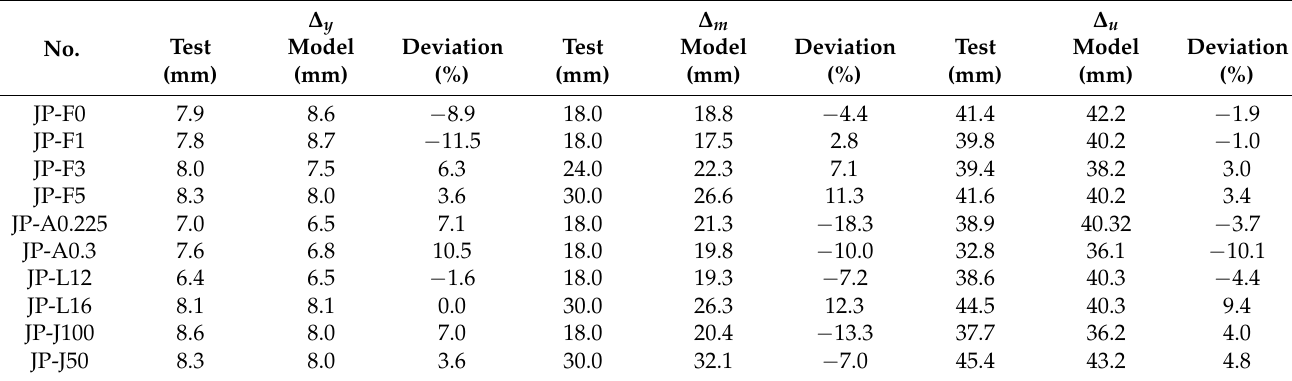
Table 8. Comparison of displacement test value and calculation